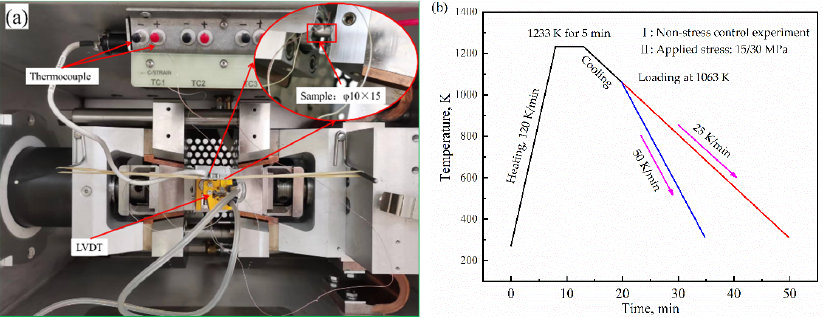
Figure 2. Experimental procedure. ( a ) photos of the experimental process; ( b ) scheme of the proposed thermomechanical cycles. thermomechanical